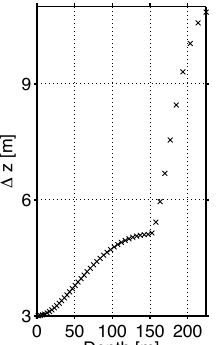
Fig. 3. Total river runoff applied in MOMBA in units Sv ( =10 6 m 3 s − 1 ).